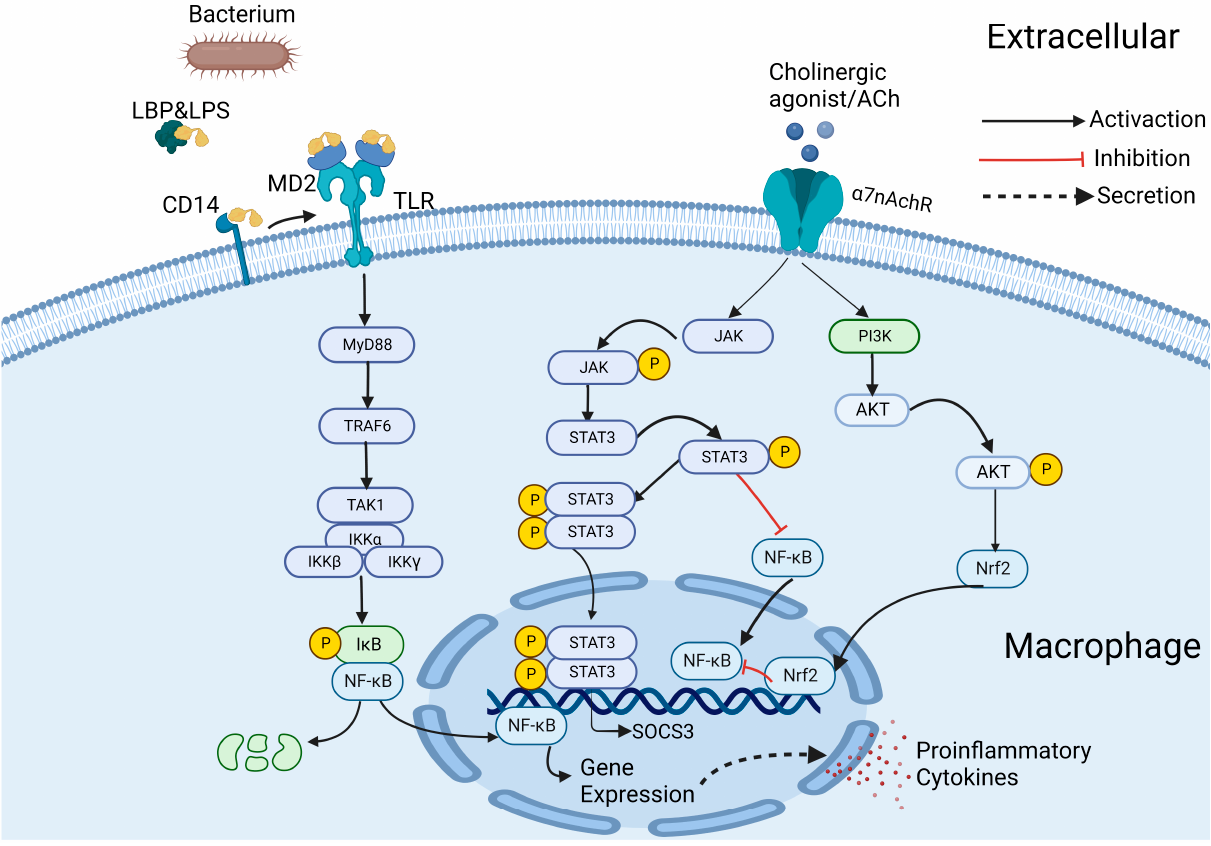
Figure 3. Brief Description of Signal Transduction associated with α 7nAChR in the cholinergic anti- inflammatory pathway. Abbreviations: ACh, acetylcholine; LPS, lipopolysaccharide; LBP, lipopolysaccha-ride-binding protein; TLR, Toll-like receptor; MD2, myeloid differentiation protein 2; MyD88, myeloid differentiation factor 88; TRAF6, Tumor necro-sis factor receptor-associated factors 6; TAK1, TGF-beta-activated kinase-1; NF- κ B, nuclear factor- κ B; I κ B, NF-kappa-B inhibitor; IKK, inhibitor of I κ B kinases; PI3K, phosphatidylinositol-3-kinase; AKT, protein kinase B; STAT3, signal transducer and activator of transcription 3; JAK, Janus Kinase; Nrf2, nuclear factor erythroid 2– related factor 2; SOCS3, suppressor of cytokine signaling 3; P, phosphorylation. Figure created with BioRender.com (accessed on December 30th, 2022).